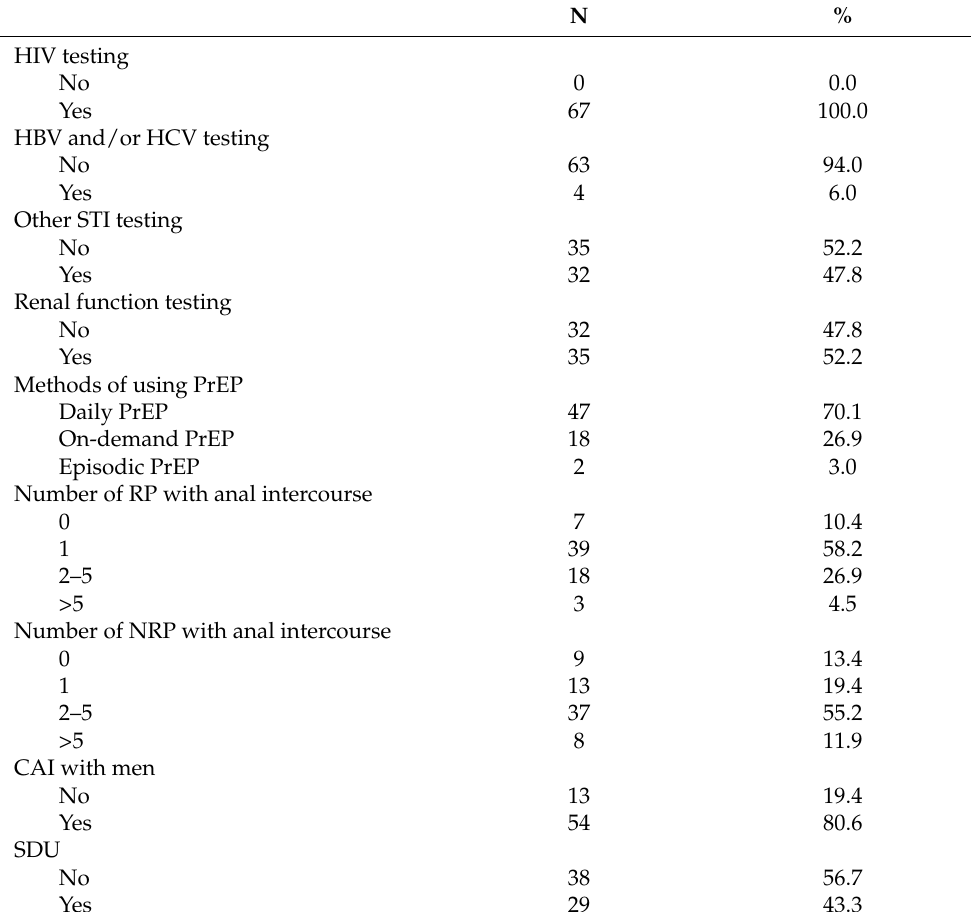
Table 2. HIV, HBV and/or HCV, other STI and renal function testing, methods of PrEP use and sexual behaviors during the follow-up period measured at Month 3 (among participants being followed up at Month 3, n =